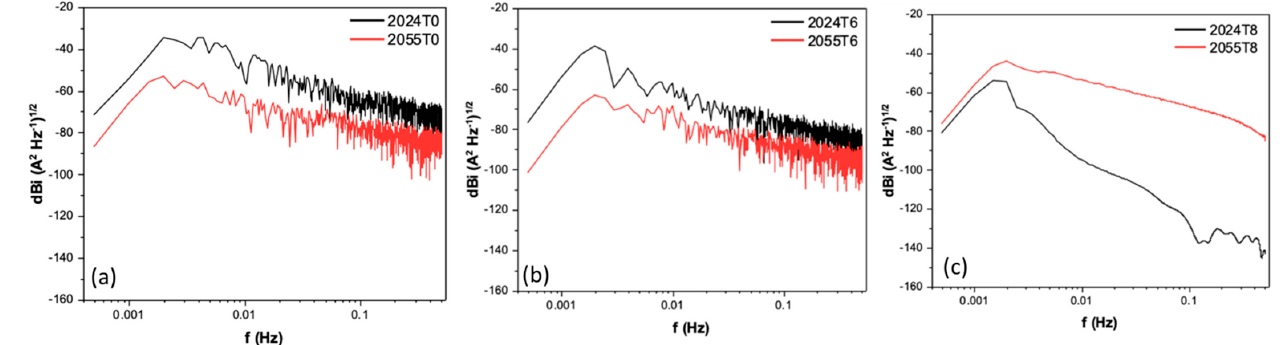
Figure 11. Power spectral density (PSD) in current, for aluminum alloys under ( a ) T0, ( b ) T6, and ( c ) T8 heat treatment conditions, exposed to a 3.5 wt. % H 2 SO 4 solution.